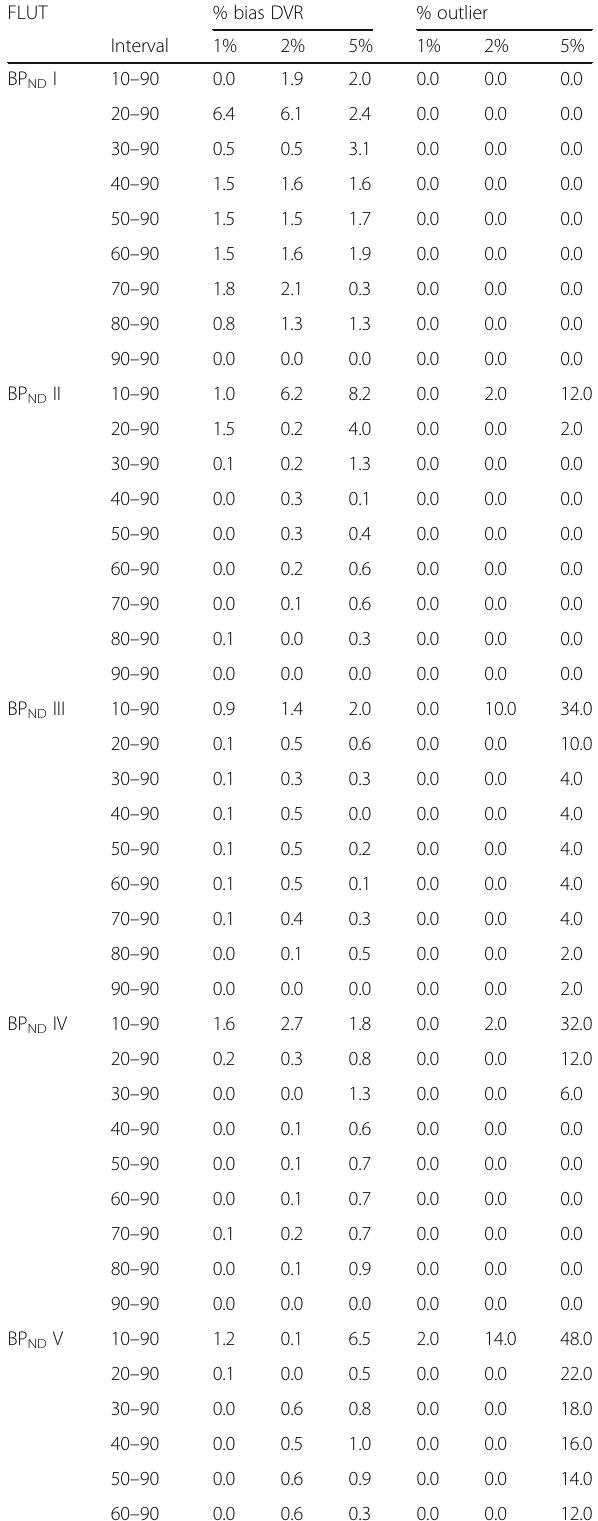
Table 3 Bias in DVR and outliers as a result of noise and the dual-time-window protocol for SRTM-generated